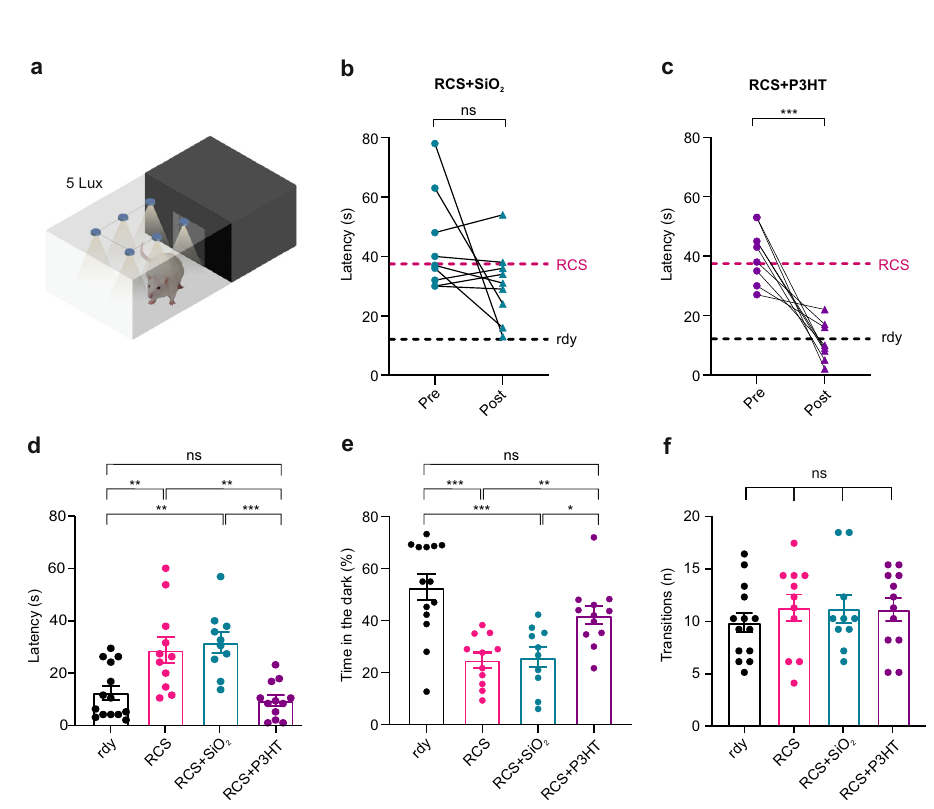
Fig. 6 Restoration of light-escape behavior in aged dystrophic RCS rats injected with P3HT-NPs. a Schematics of the apparatus for assessing light- driven behavior (light – dark box test). Thirty days after injection (DPI) of P3HT or SiO 2 (sham) NPs, aged RCS rats together with age-matched untreated RCS rats and healthy rdy controls were placed in the middle of the light compartment after 30 min of dark adaptation and irradiated with a 5-lux white source. The trial was performed 1 month before (Pre) and 1 month after (30 DPI; Post) the subretinal injection of either inert SiO 2 - ( left ) or P3HT- ( right ) NPs by measuring the latency of escape from the illuminated side to the dark compartment, the percentage time spent in the dark compartment and the overall motor activity (number of transitions between the two compartments). b , c Individual pre- and post-injection light-escape latencies in RCS rats sham-injected with SiO 2 -NPs ( b ) or injected with P3HT-NPs ( c ). The red and black horizontal lines refer to the average latency values determined in age- matched, untreated rdy controls and RCS rats, respectively. A signi fi cant reduction of light-escape latency between pre- and post-treatment was observed in aged RCS rats injected with P3HT-NPs (RCS + P3HT), as compared to sham-injected (RCS + SiO 2 ) RCS rats. Paired Student ’ s t -test. Sample size: n = 13, 10, 9, and 9 for rdy, RCS, RCS + SiO 2 and RCS + P3HT, respectively. d – f The light-driven behavior of all experimental groups of 11-months-old rats was evaluated based on latency ( d ) and the percentage time spent in the dark compartment ( e ). The number of transitions between the two compartments was also monitored to check for the absence of motor impairments ( f ). P3HT-NP injected RCS rats, but not untreated or sham-injected RCS rats, display a full recovery in both escape latency and percentage time spent in the dark as compared to untreated healthy rdy controls. One-way ANOVA/Tukey ’ s multiple comparison tests. Sample size n = 14, 11, 10, and 12 for rdy, RCS, RCS + SiO 2 and RCS + P3HT, respectively. Data are means ± sem with superimposed individual experimental points. * p < 0.05, ** p < 0.01, *** p < 0.001. For exact p -values and source data, see Source data fi